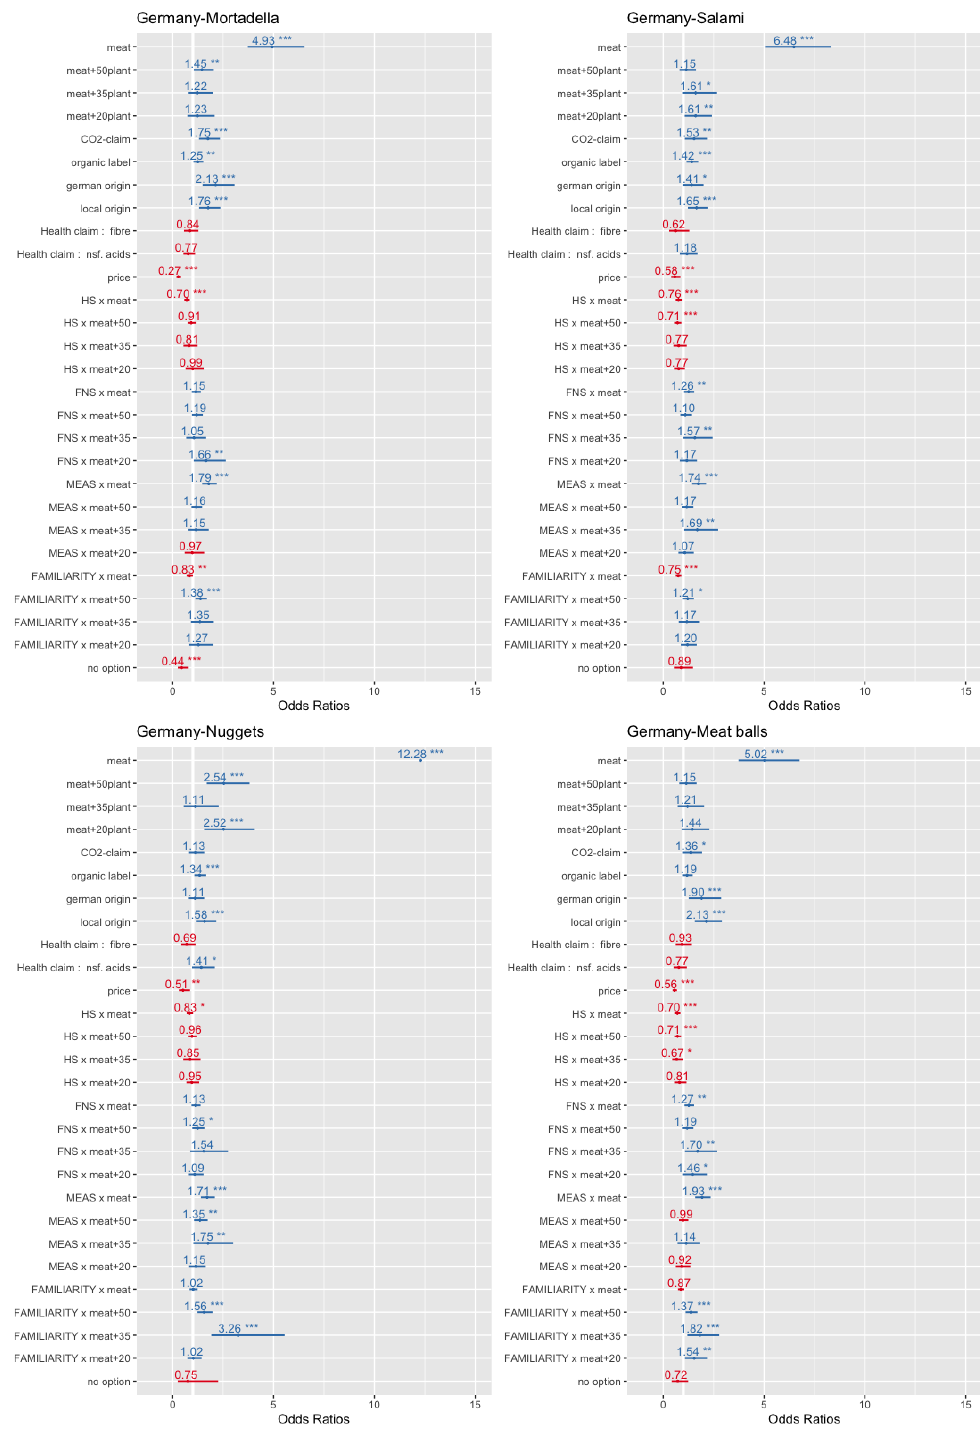
Figure 2. Odds ratios—estimations for Germany. ∗ p < 0.1; ∗∗ p < 0.05; ∗∗∗ p <